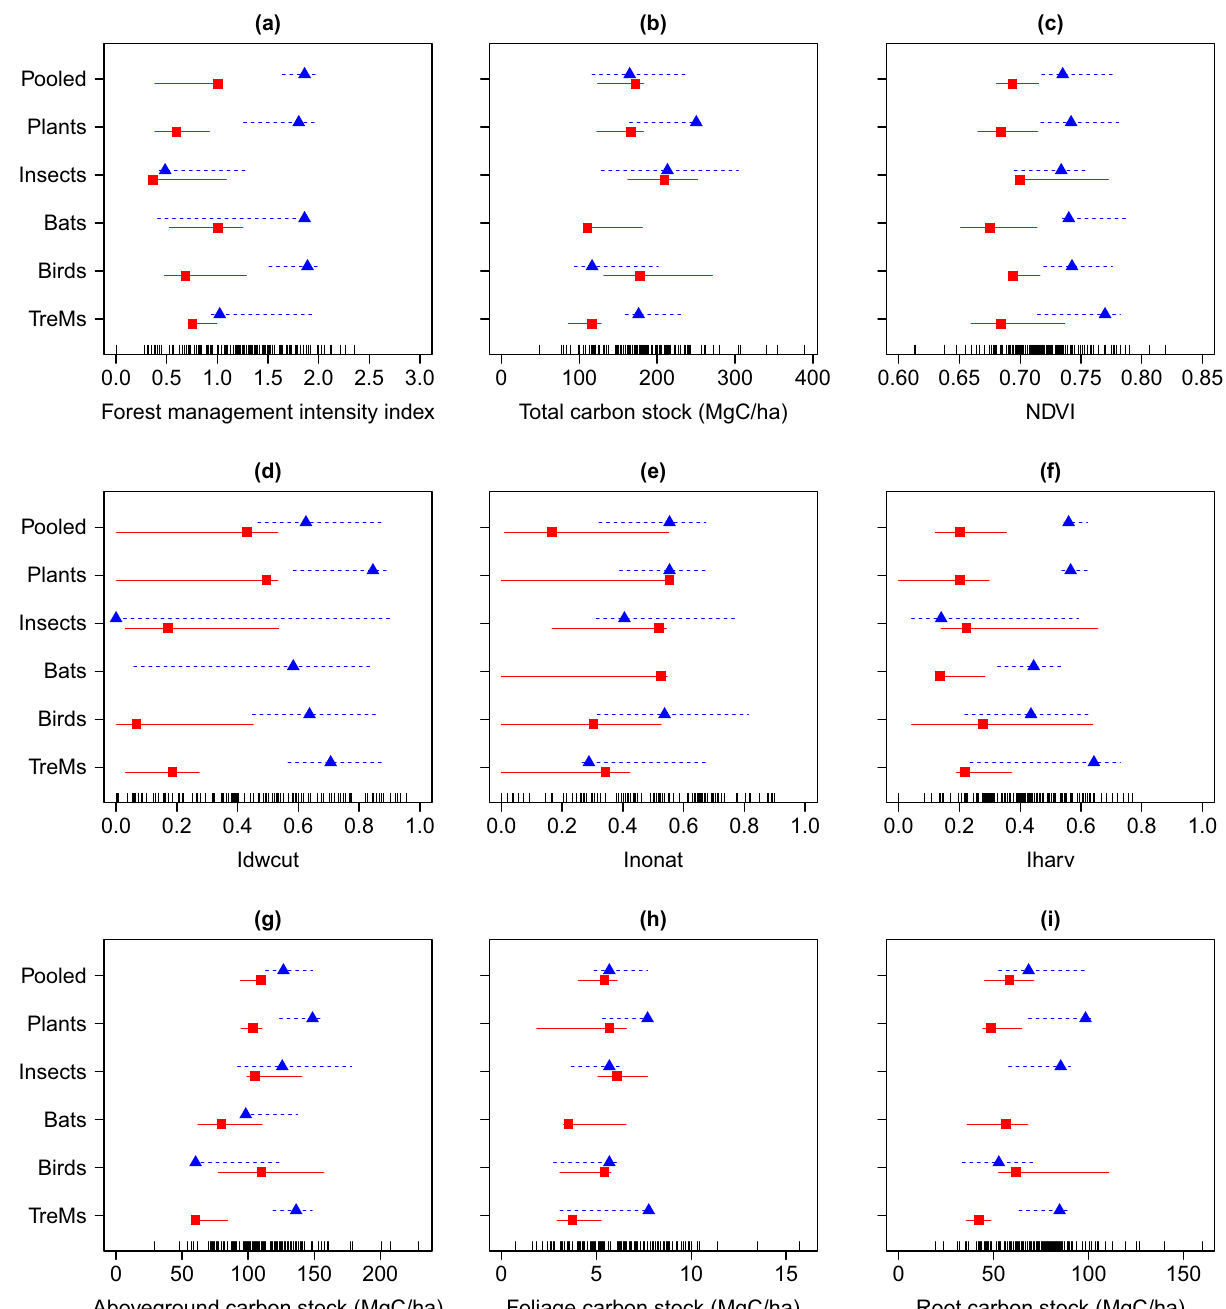
Figure 3. Change points of the aggregated sum(z−) and sum(z+) values for pooled richness, the species groups and tree-related microhabitats. These change points indicate where, along the gradients, species increase (positive, blue triangle) or decrease (negative change point, red square) their frequency. If symbols are missing, the respective group did not show a reliable negative or positive change along the gradient. Evidence for community-level thresholds among negative and positive taxa is assessed separately by tabulating and summing all negative change points (z−) and positive change points (z+) scores 39 . Sharp, nonlinear responses in taxon richness are reflected by relatively narrow intervals between upper and lower change point quantiles (5%, 95%), indicated by shorter whiskers. In cases where a species group shows a linear or more gradual response, they have broad whiskers spanning most of the range of the predictor. This graph was produced in R using the TITAN2 package 39